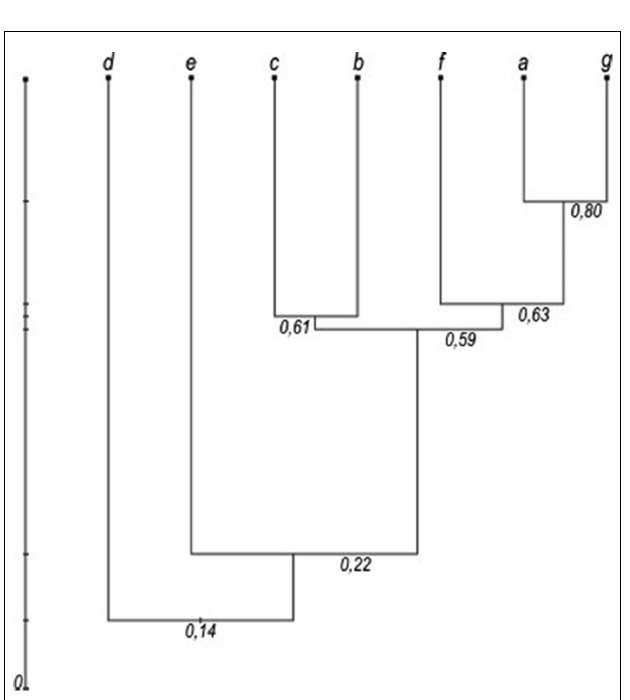
FIGURE 4 | Dendrogram based on the modified Sorensen coefficient of similarity between the surveyed lagoons: (a) Salgados (1), (b) Nova (2), (c)Antiga (2), (d)Almargem (3), (e) Dunas Douradas (4), (f) Garrão (4), and (g) Quinta das Salinas (4), (numbers in brackets refer to Figure 1).